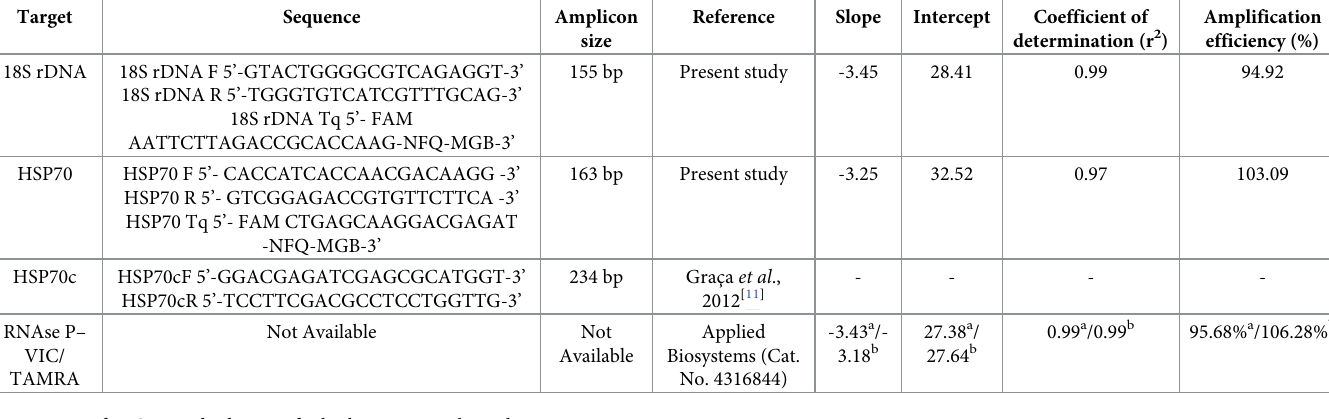
Parameters of qPCR standard curves for both targets are showed. a qPCR standard curve values for RNAse P in multiplex with 18S rDNA. b qPCR standard curve values for RNAse P in multiplex with